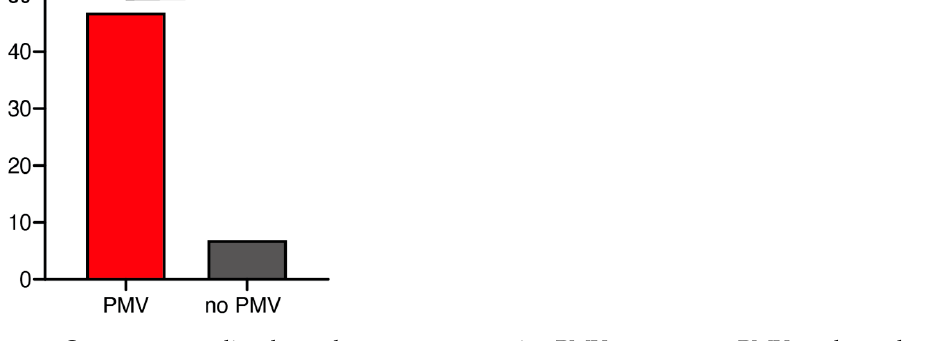
Figure 1. One-year mortality dependent on postoperative PMV occurrence. PMV, prolonged me- chanical ventilation.